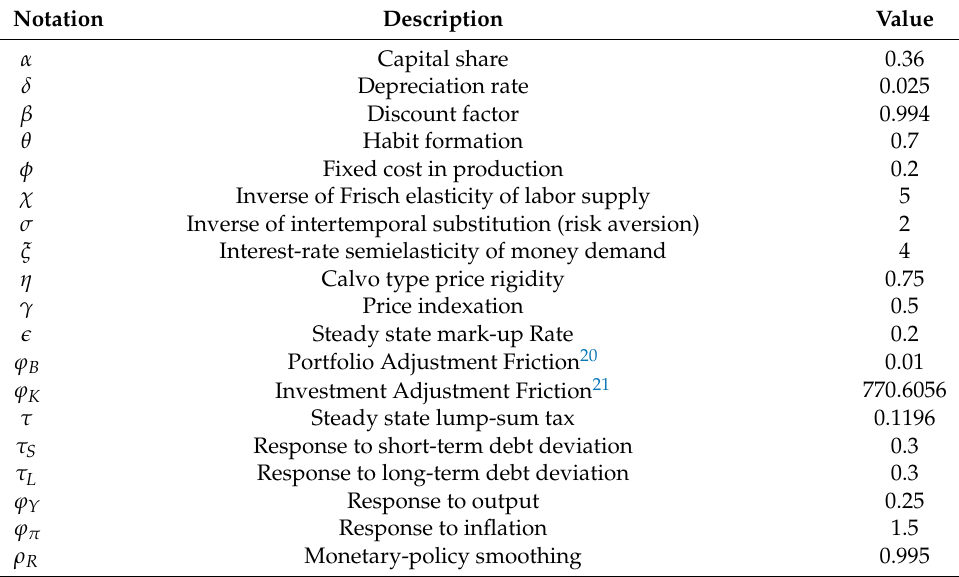
Table 2. Calibration for structural and policy